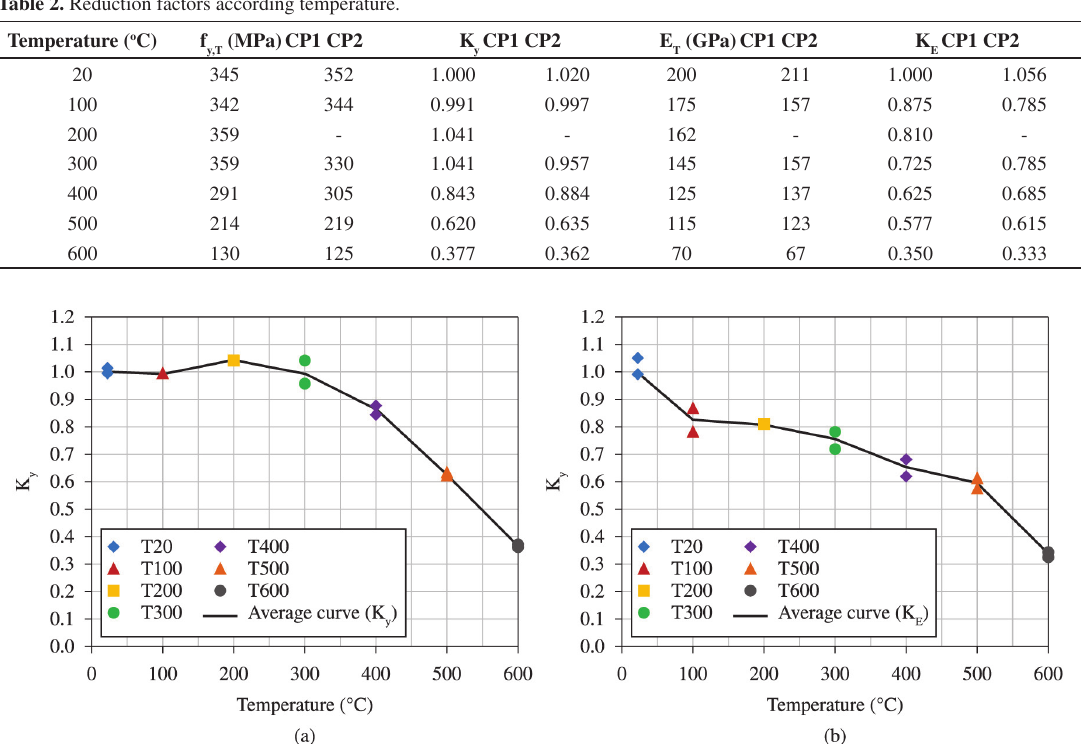
Figure 7. Reduction factors points for each specimen according temperature and average curves: (a) yield strength K modulus K E